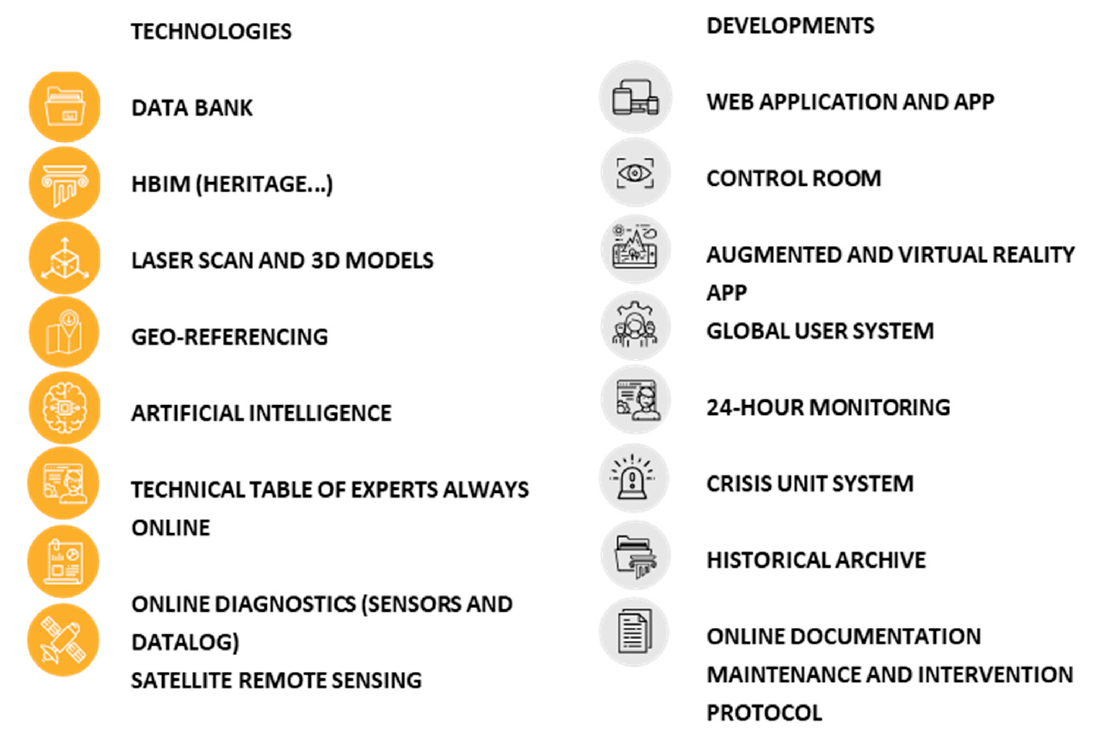
Figure 2. SyPEAH, technologies employed and expected developments.